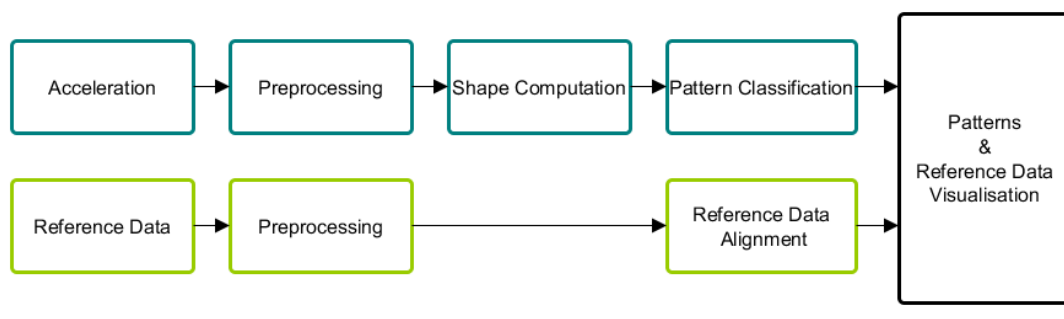
Figure 2. Overview of data